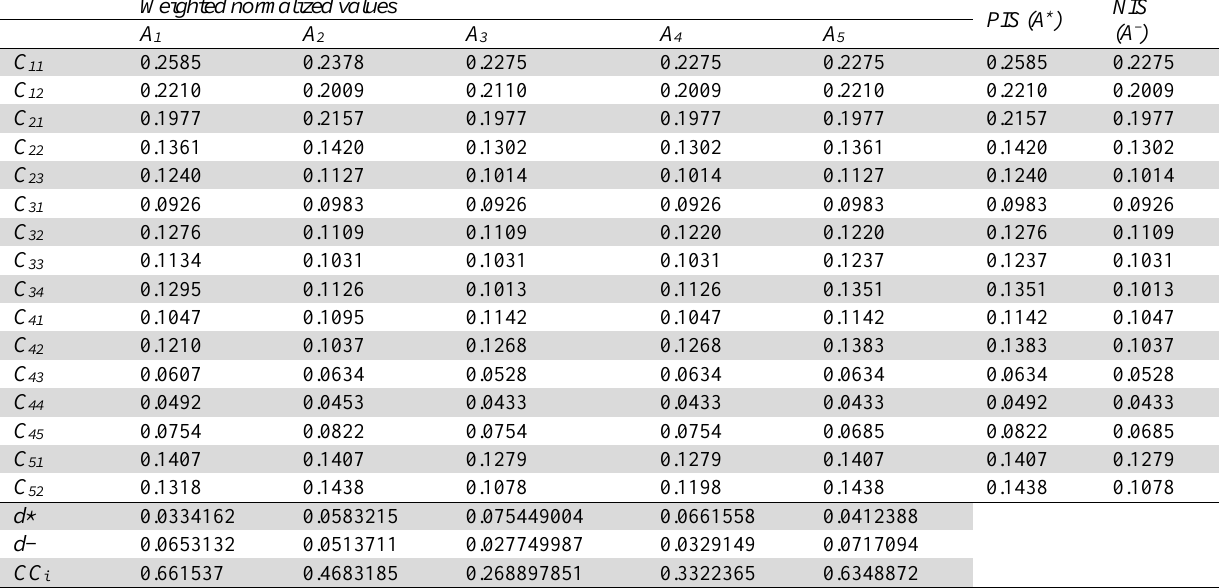
Calculation steps of the TOPSIS method for the location